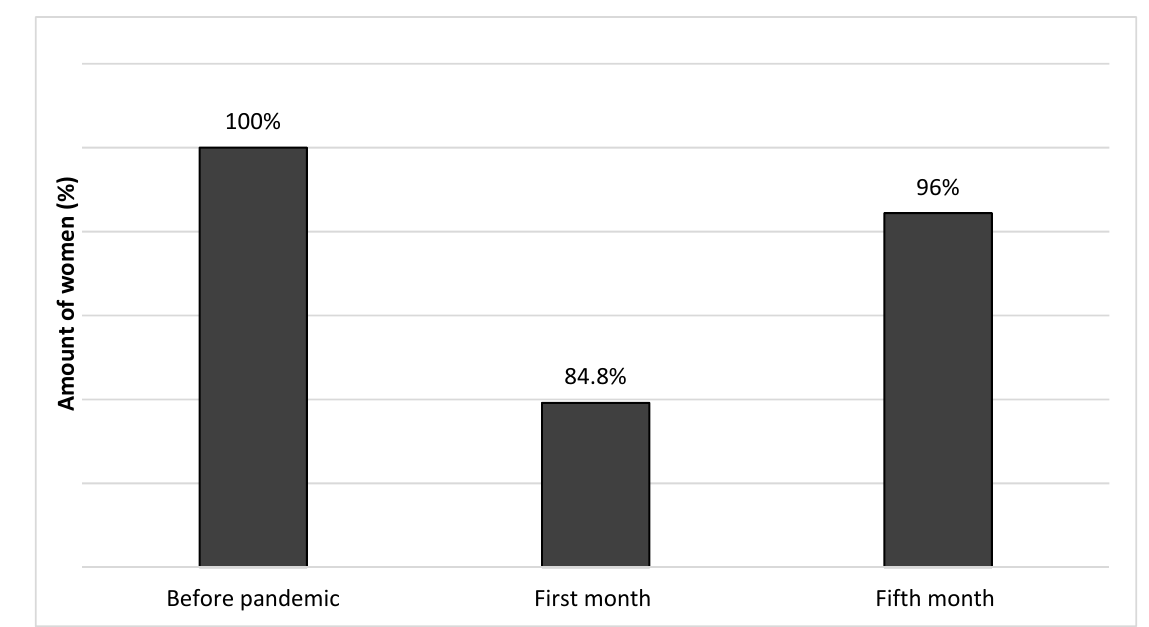
Figure 1. Percentage of sexual intercourse before, in the first month and in the fifth month of the pandemic.